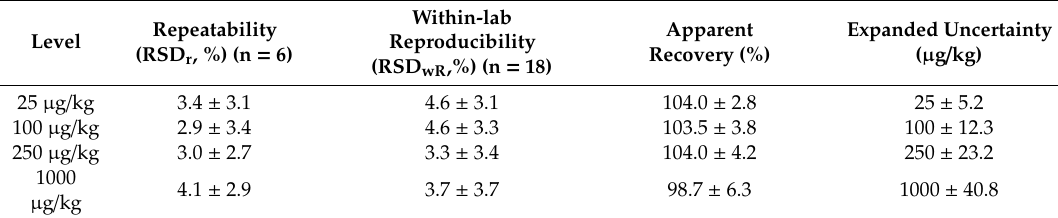
Table 2. Parameters obtained for the calibration curve.